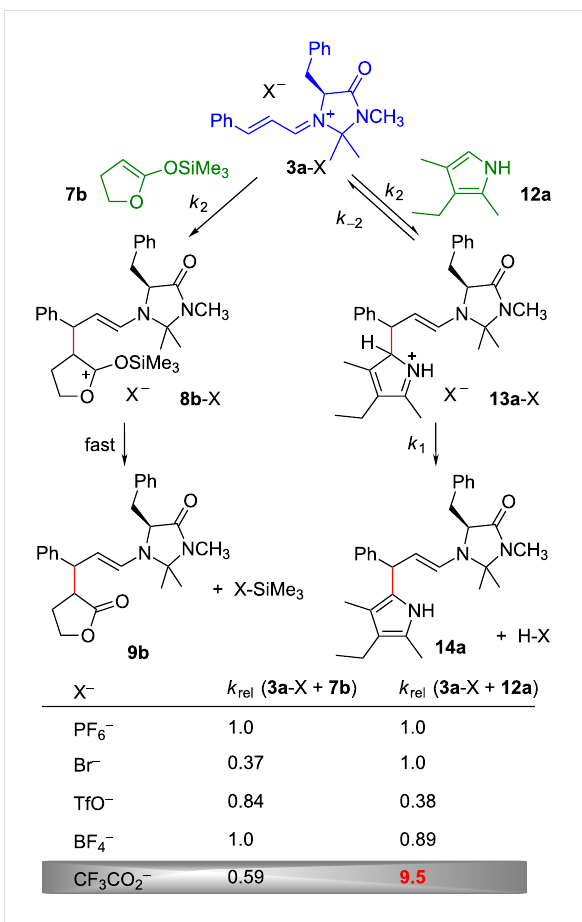
Figure 8: Counterion effects in electrophilic reactions of iminium ions 3a -X (at 20 °C, silyl ketene acetal 7b in dichloromethane with c ( 3a - CF 3 CO 2 ) = (1.7–2.5) × 10 − 5 M, kryptopyrrole 12a in acetonitrile with c ( 3a -CF 3 CO 2 ) = 5.0 × 10 − 5